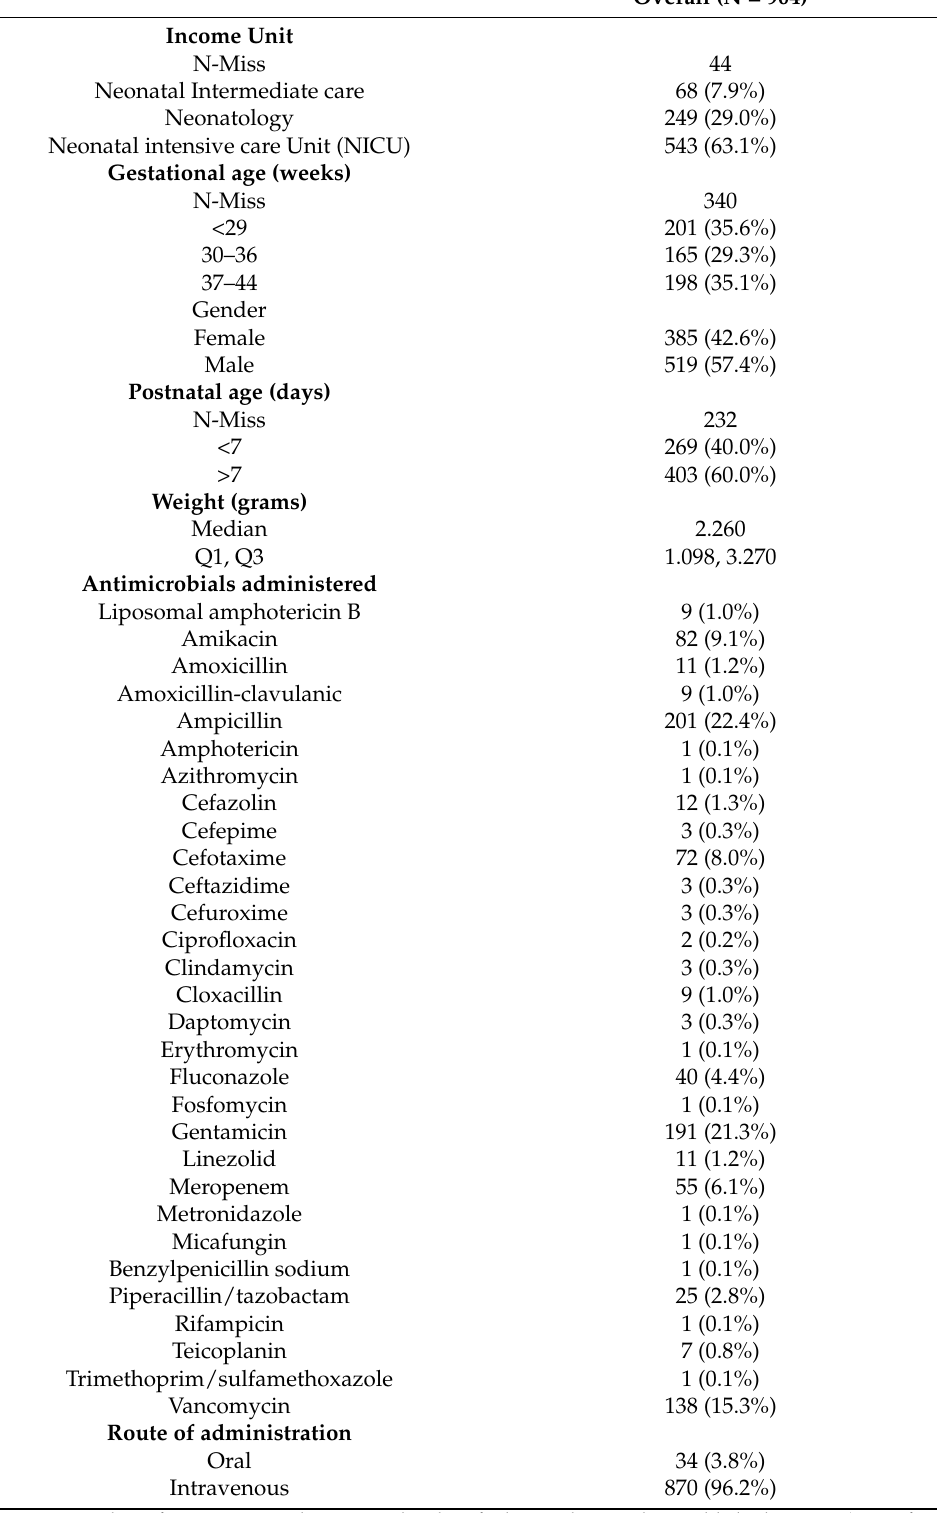
Table 2. Demographic characteristics of the neonates and the treatments